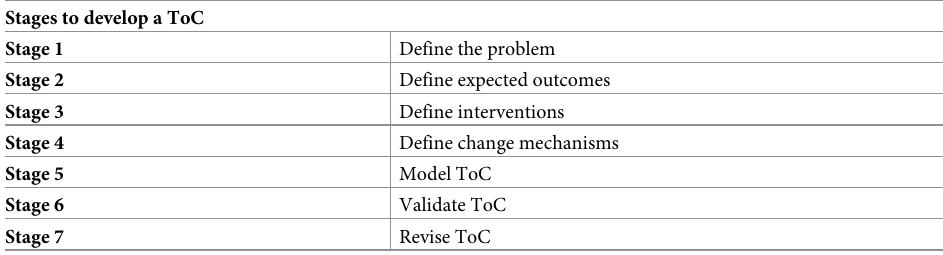
Table 5. Stages for ToC